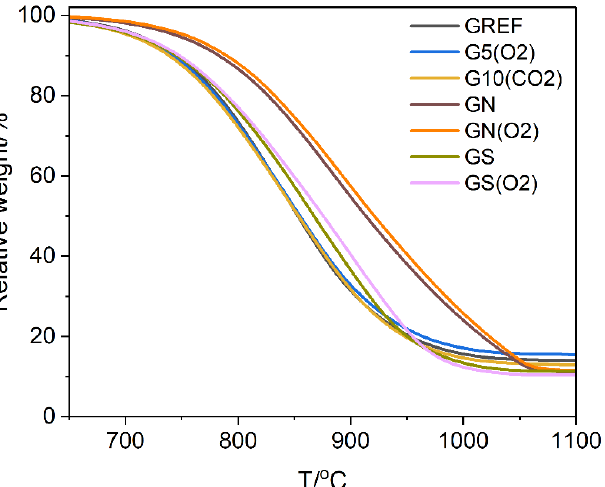
Figure 6. Thermal stability of acid and plasma ‐ treated materials. Reference graphite (GREF) and plasma oxidized samples: treated with O 2 plasma for 5 min ‐ G5(O2), treated with CO 2 plasma for 10 min G10(CO2), treated with nitric acid (GN), and treated with sulfuric acid (GS), GS(O2) and GN(O2) ‐ acid washed samples treated with O 2 plasma for 10 min.